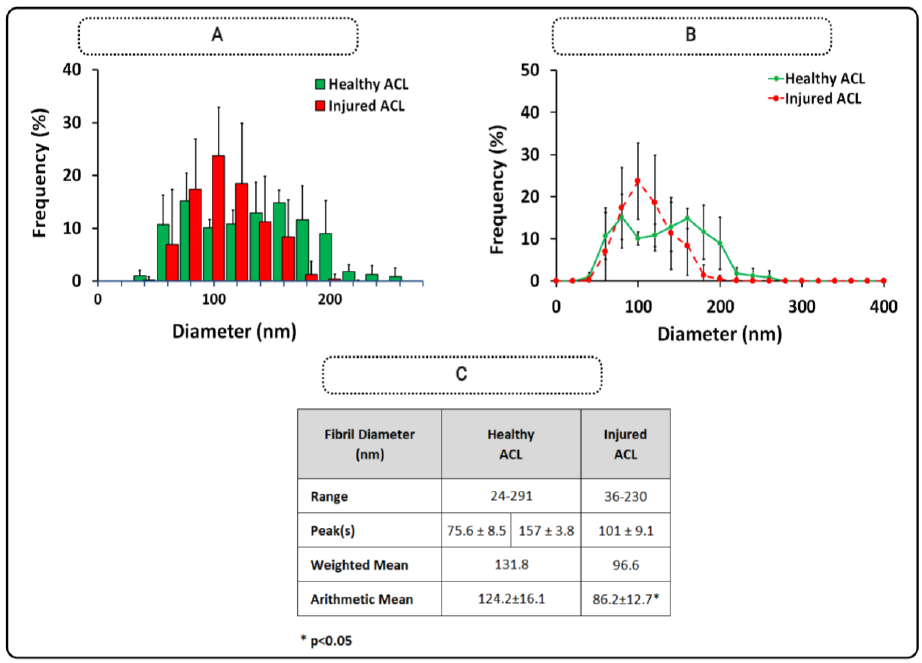
Figure 3. Diameter distributions of injured and healthy ACL collagens ( A ) and line graph ( B ) with descriptive statistics ( C ). * shows statistical difference at p < 0.05 ( n = 4/group), and error bars represent standard deviation.